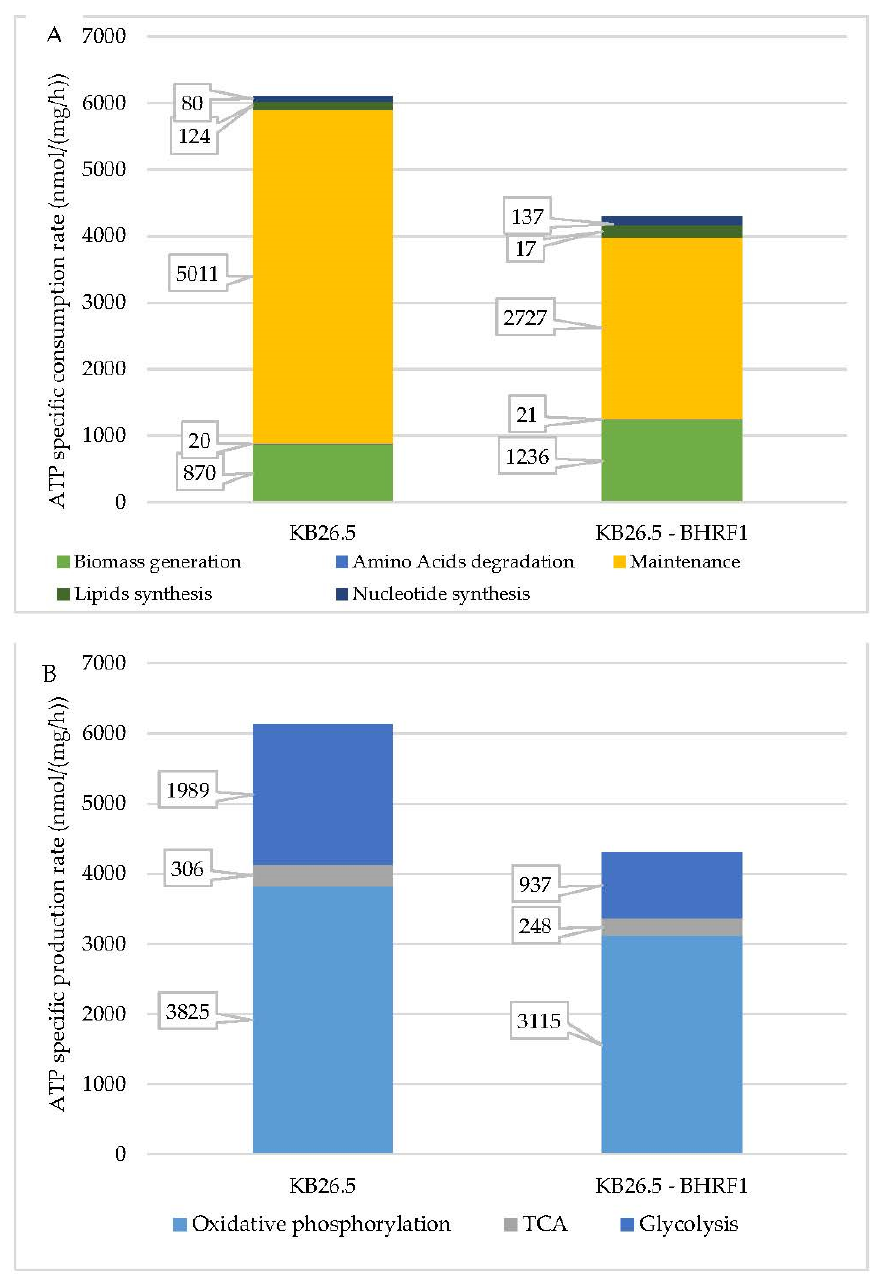
Figure 6. Distribution of ATP generation (concerning the reaction in which ATP was generated) and consumption in the KB26.5 and KB26.5-BHRF1 cell lines. ATP generation ( A ) and consumption ( B ) (nmol ATP/ (mg DCW·h)). ( B ) (nmol ATP/ (mg DCW ·